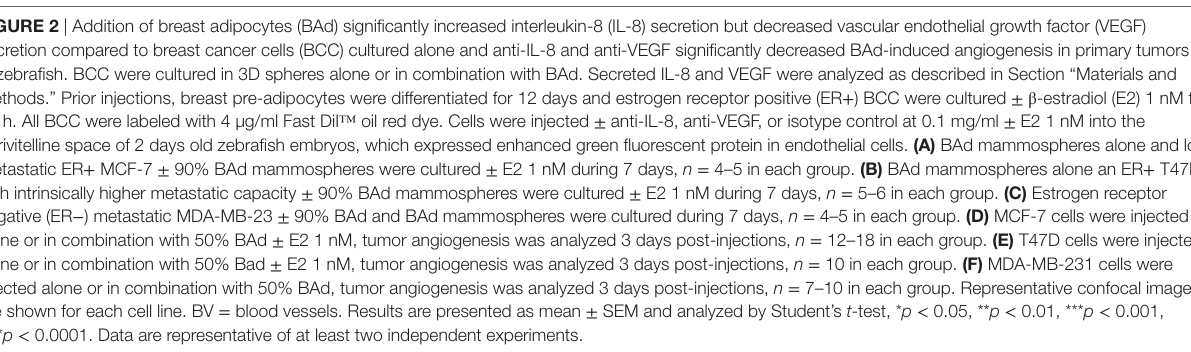
FigUre 2 | Addition of breast adipocytes (BAd) significantly increased interleukin-8 (IL-8) secretion but decreased vascular endothelial growth factor (VEGF) secretion compared to breast cancer cells (BCC) cultured alone and anti-IL-8 and anti-VEGF significantly decreased BAd-induced angiogenesis in primary tumors in zebrafish. BCC were cultured in 3D spheres alone or in combination with BAd. Secreted IL-8 and VEGF were analyzed as described in Section “Materials and Methods.” Prior injections, breast pre-adipocytes were differentiated for 12 days and estrogen receptor positive (ER + ) BCC were cultured ± β -estradiol (E2) 1 nM for 48 h. All BCC were labeled with 4 µg/ml Fast DiI ™ oil red dye. Cells were injected ± anti-IL-8, anti-VEGF, or isotype control at 0.1 mg/ml ± E2 1 nM into the perivitelline space of 2 days old zebrafish embryos, which expressed enhanced green fluorescent protein in endothelial cells. (a) BAd mammospheres alone and low metastatic ER + MCF-7 ± 90% BAd mammospheres were cultured ± E2 1 nM during 7 days, n = 4–5 in each group. (B) BAd mammospheres alone an ER + T47D with intrinsically higher metastatic capacity ± 90% BAd mammospheres were cultured ± E2 1 nM during 7 days, n = 5–6 in each group. (c) Estrogen receptor negative (ER − ) metastatic MDA-MB-23 ± 90% BAd and BAd mammospheres were cultured during 7 days, n = 4–5 in each group. (D) MCF-7 cells were injected alone or in combination with 50% BAd ± E2 1 nM, tumor angiogenesis was analyzed 3 days post-injections, n = 12–18 in each group. (e) T47D cells were injected alone or in combination with 50% Bad ± E2 1 nM, tumor angiogenesis was analyzed 3 days post-injections, n = 10 in each group. (F) MDA-MB-231 cells were injected alone or in combination with 50% BAd, tumor angiogenesis was analyzed 3 days post-injections, n = 7–10 in each group. Representative confocal images are shown for each cell line. BV = blood vessels. Results are presented as mean ± SEM and analyzed by Student’s t -test, * p < 0.05, ** p < 0.01, *** p < 0.001, **** p < 0.0001. Data are representative of at least two independent